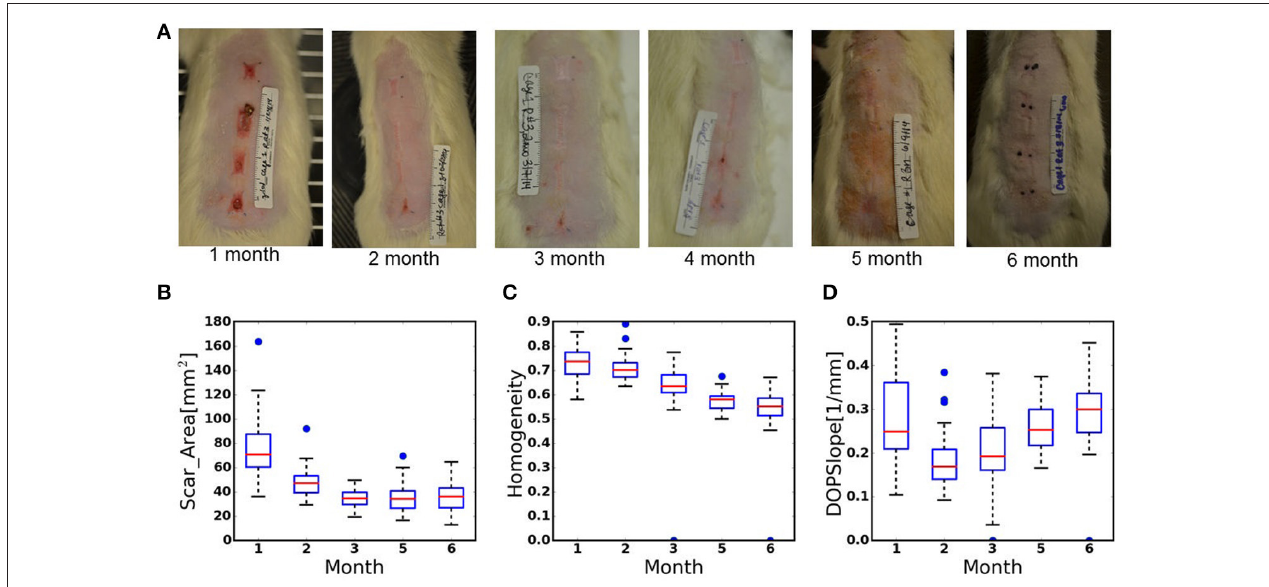
FIGURE 1 | (A) Digital images of scar remodeling over time up to 6 months after third-degree burn injury. (B–D) Box-plots of the data recorded from the scars during 6 months of healing. (B) . Scar_Area, (C) . Homogeneity of birefringence, (D) . The slope of the DOP. Plot annotations were defined as follows. Boxes: the main body of the boxplot showing the quartiles and the median’s confidence intervals if enabled. Medians: horizontal lines at the median of each box. Whiskers: the vertical lines extending to the most extreme, non-outlier data points. Caps: the horizontal lines at the ends of the whiskers ( n = 36 wounds, 9 animals).